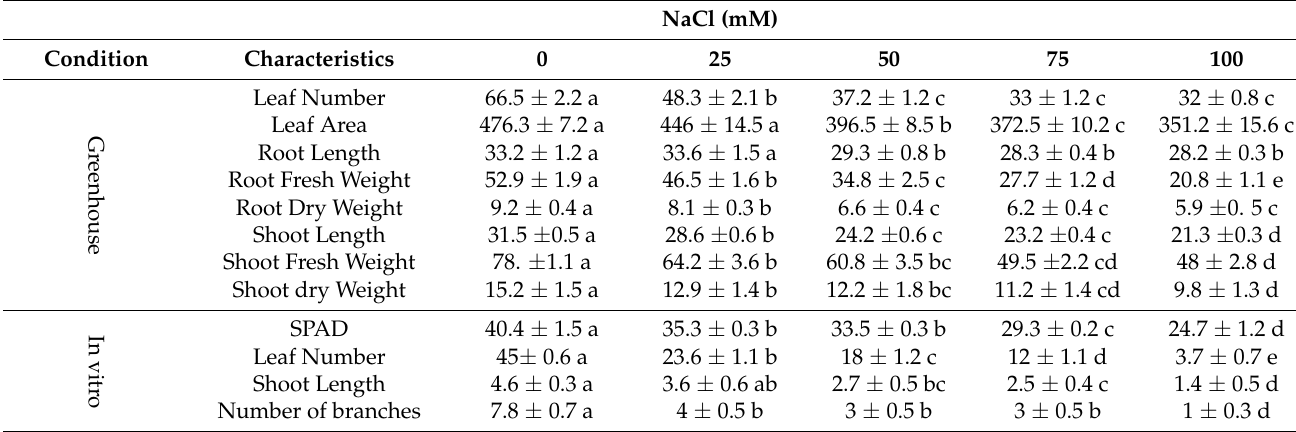
Table 2. Effect of salinity stress on physiological parameters measured in the greenhouse and in vitro. NaCl